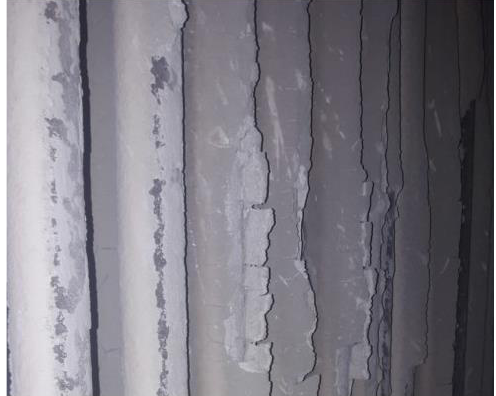
Figure 18. Slag deposits on the water wall surface.